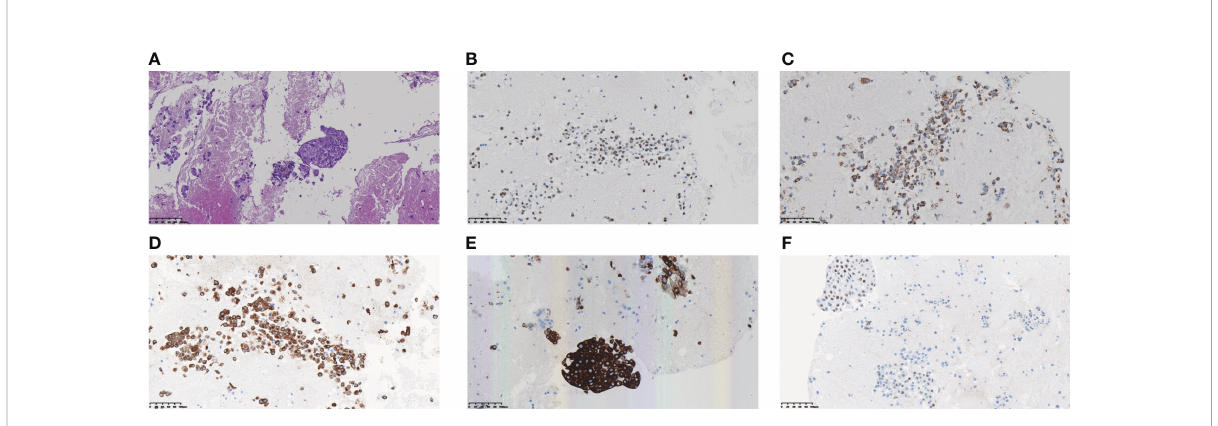
FIGURE 2 Morphology and immunohistochemistry con fi rmed the diagnosis of lung adenosquamous carcinoma by pathologists (A) H&E staining; (B) Positive staining of TTF-1 by immunochemistry; (C) Positive staining of Napsin A; (D) Positive staining of CK7; (E) Positive staining of CK5/6; (F) Positive staining of